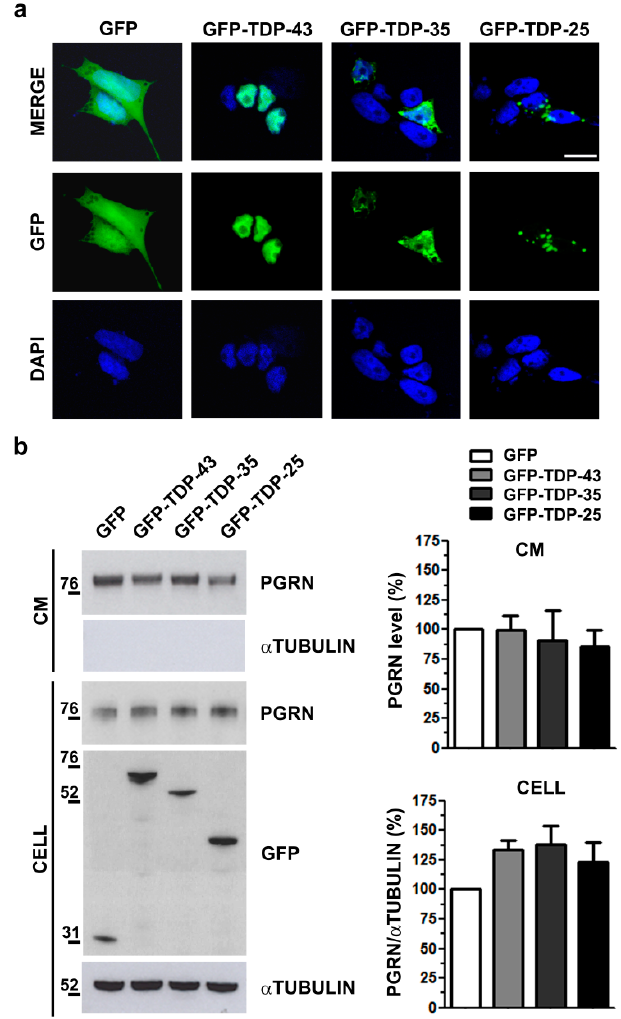
Figure 4. PGRN protein content and secretion in human TDP-43 GOF cells. ( a ) Representative immunofluorescence images showing the subcellular localization of the recombinant GFP-TDP-43 full-length and C-terminal fragments (GFP-TDP-35; GFP-TDP-25) in human neuroblastoma M17 cells. DAPI (blue) was used for nuclei staining. Scale bar: 10 µm. ( b ) Representative WB images and densitometric analyses of PGRN protein content in cell lysates (CELL) and conditioned media (CM) of M17 cells transfected as indicated. Anti-GFP immunoblot shows the transfection e ffi ciency and α Tubulin was used for sample normalization of the intracellular protein content and as non-secreted control protein in CM (mean ± s.e.m.; n = 3 independent experiments; one-way ANOVA and Bonferroni’s multiple comparison post hoc